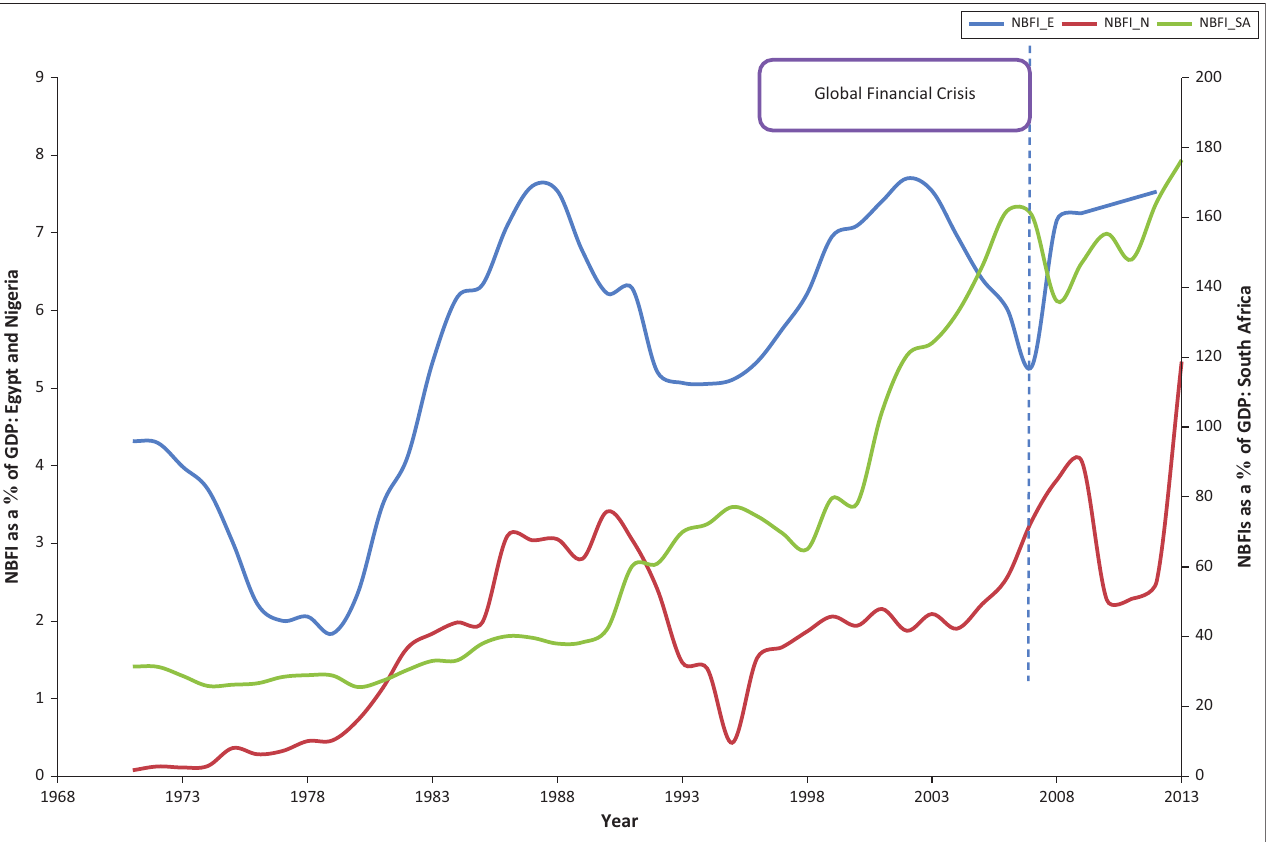
FIGURE 2: Assets of non-bank financial institutions expressed as percentage of gross domestic product for Egypt, Nigeria and South Africa: